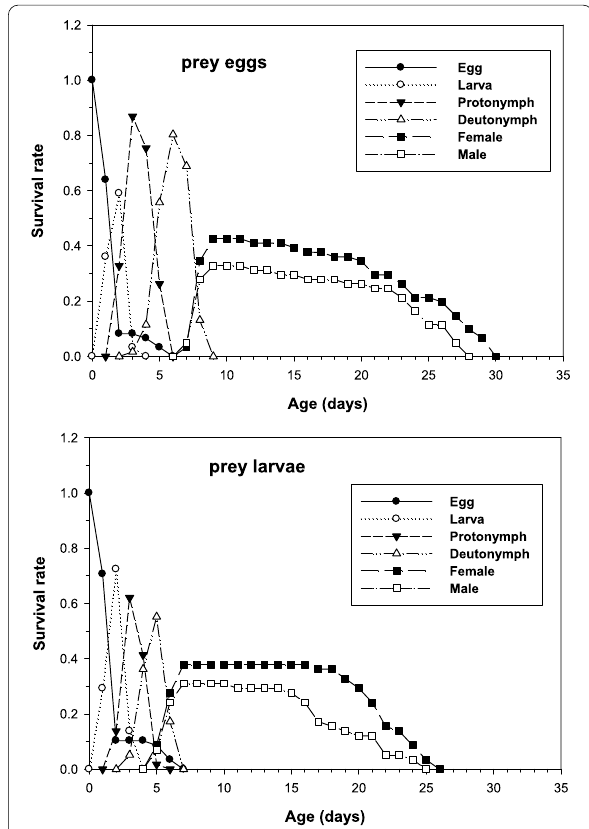
Fig. 1 Age-stage specific survival rate ( S xj ) of Blattisocius mali on eggs and larvae of Tyrophagus putrescentiae